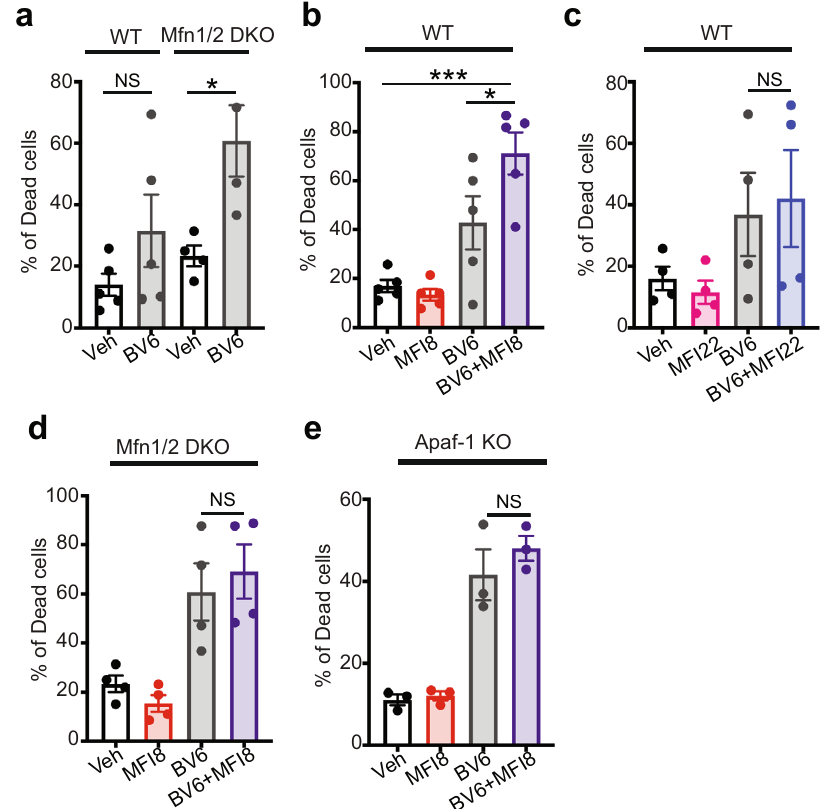
Fig. 7 MFI8 induces cell death in combination with BV6 SMAC mimetic. Evaluation of dead cells using Annexin V/PI staining as readouts via fl ow cytometry. Cells that were positive to Annexin V, PI, or both, were considered as dead. Cells were treated with MFI8 or MFI22 (20 μ M, 6 h) and BV6 (20 μ M, 6 h). a Percentage of dead cells in WT and Mfn1/Mfn2 DKO MEFs upon treatment with BV6. Data represent mean ± SEM from n = 5